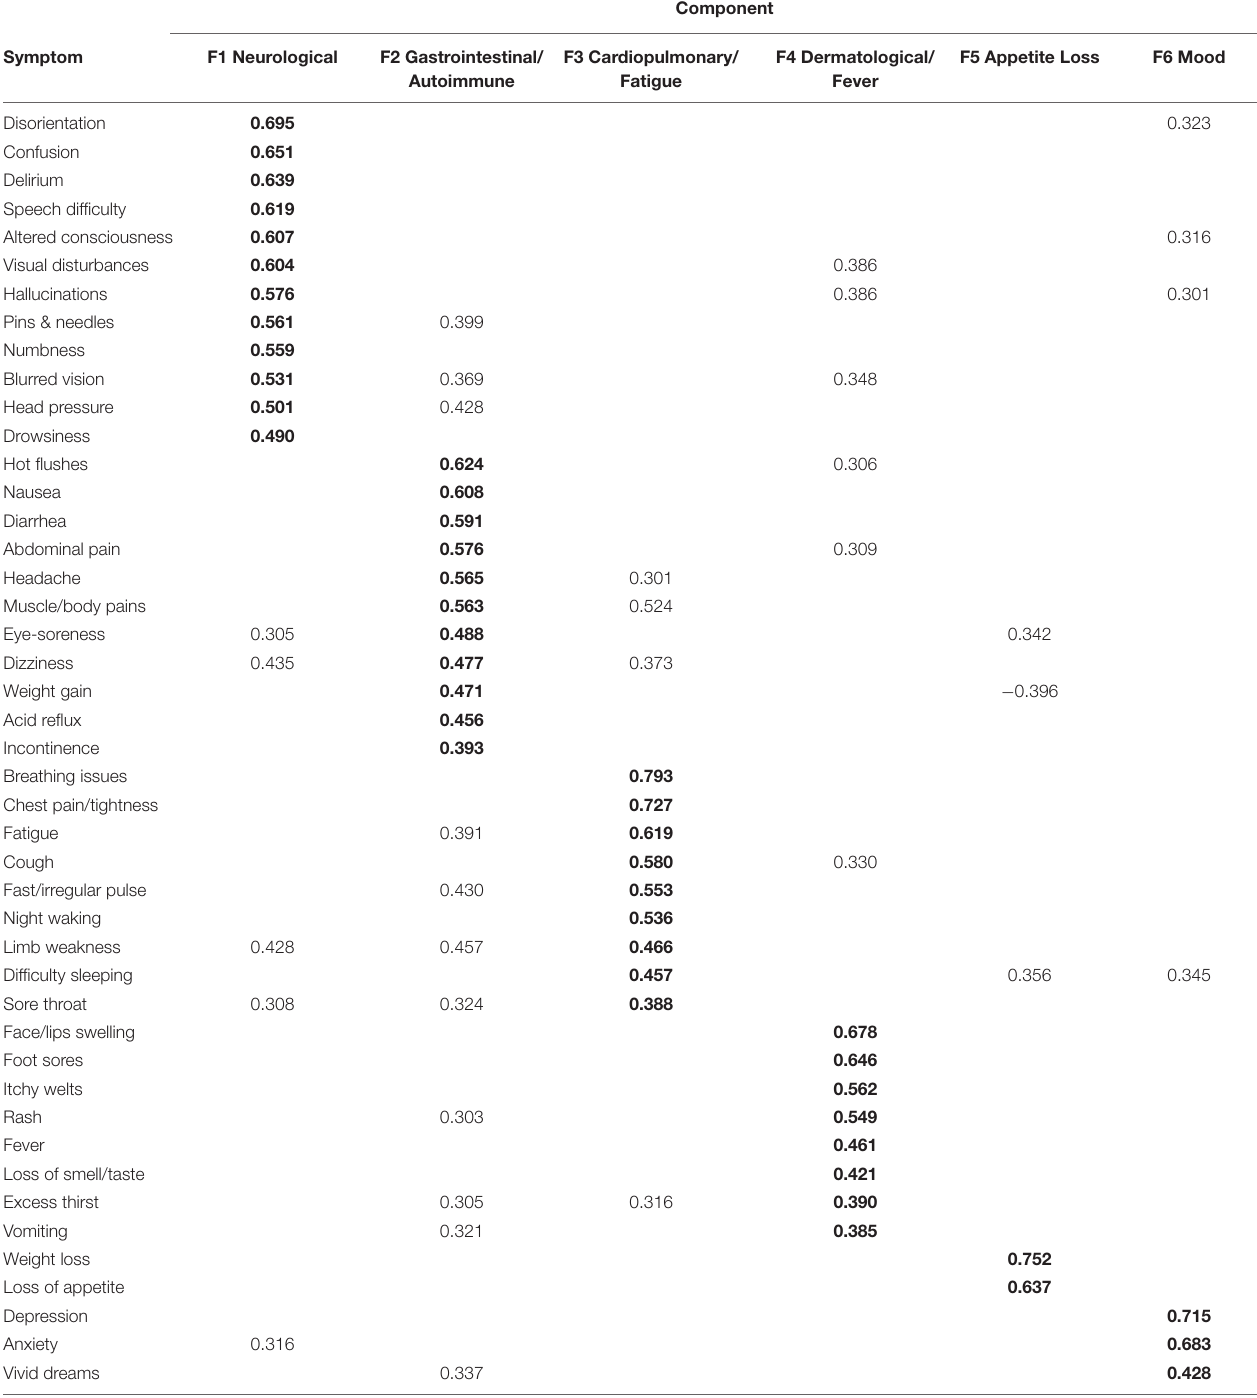
The bold indicates items loading above 0.5; non bold numbers are those loading above 0.3. Long COVID has significant impact on individuals’